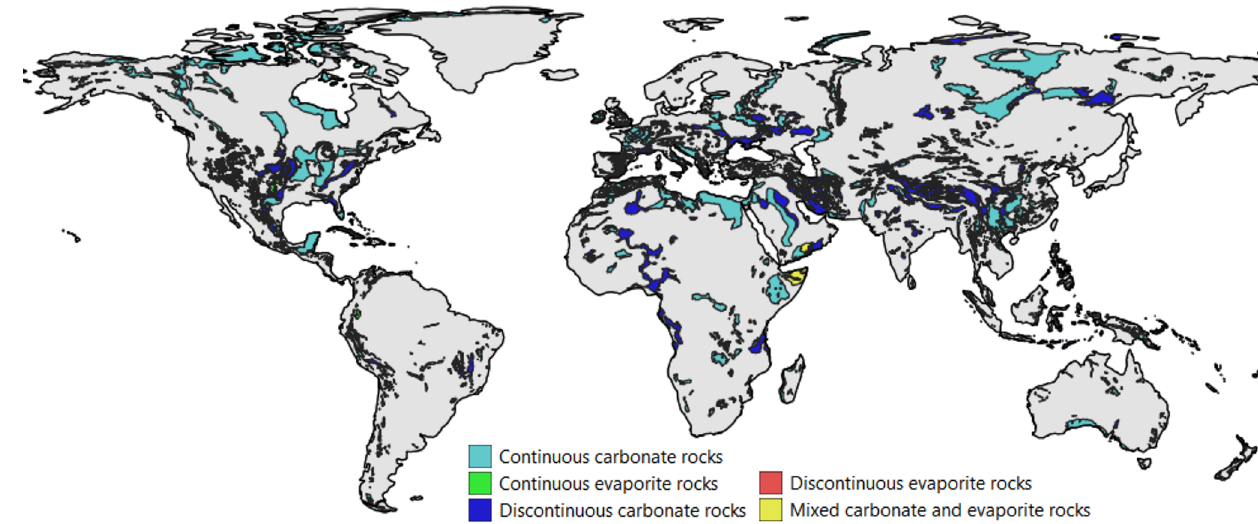
Figure 6. World Karst Aquifer Map. Cartography by the author in QGIS; data from Goldscheider, 2021.